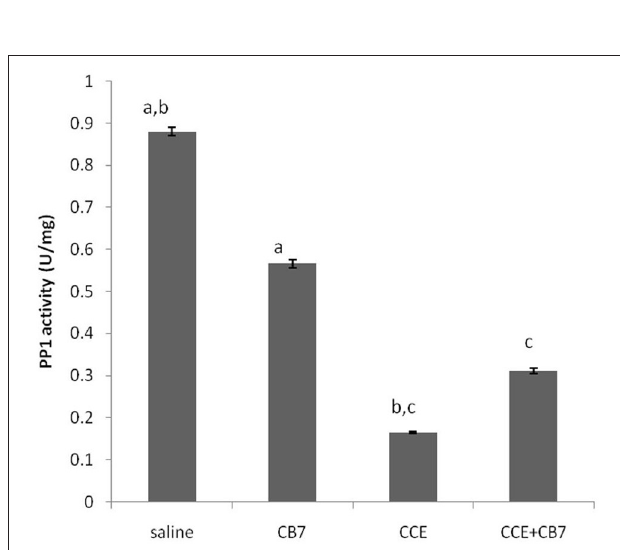
FIGURE 5 | Protein phosphatase-1 (PP1) activity in the livers of mice in each group. Data are presented as mean ± SEM. Bars with similar letters represent statistically significant differences. Ten mice per group ( n =